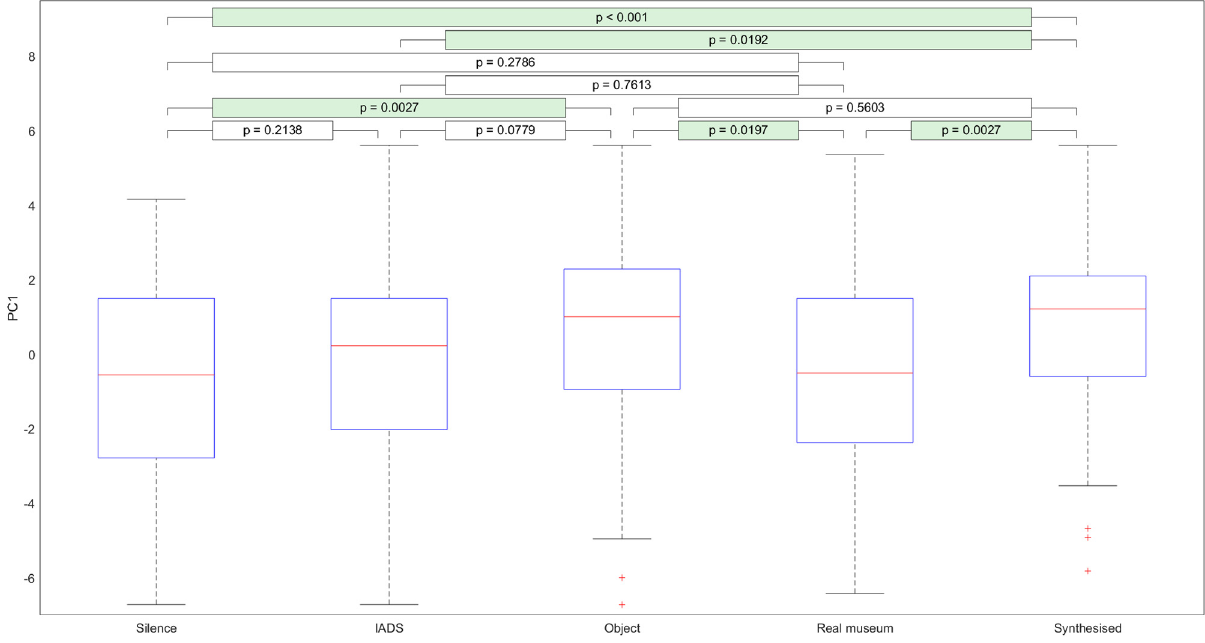
Fig 5. The distributions of values of principal component 1 across the different